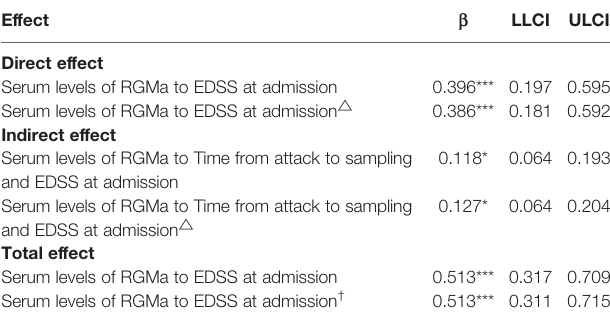
TABLE 6 | The mediating effects of time from attack to sampling between serum RGMa level and EDSS score on